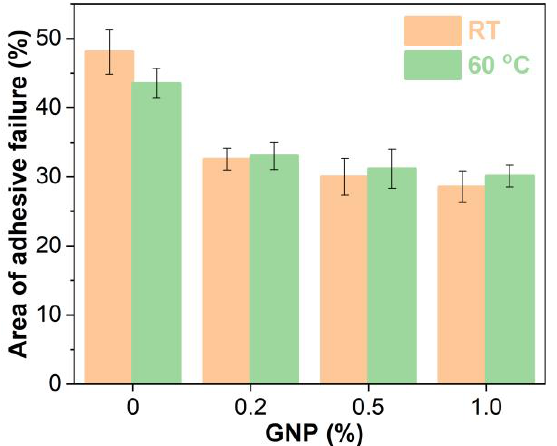
Figure 15. Area of adhesive failure on the steel plates bonded with GNP-reinforced EABCs after single-lap shear tests.